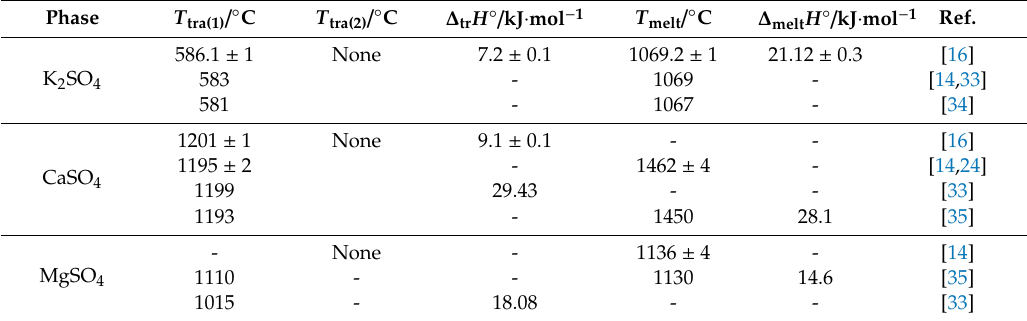
Figure 3. Differential scanning calorimetry-thermogravimetry (DSC-TGA) curves for the synthesized K 2 Ca 2 (SO 4 ) 3 phase: ( A ) phase transition temperatures, and ( B ) highlighted areas of each peak for enthalpy of phase transition or melting calculations. Table 1. Comparative summary of temperatures and enthalpies of phase transitions and melting of single phases in the K 2 SO 4 -(Mg,Ca)SO 4 system.